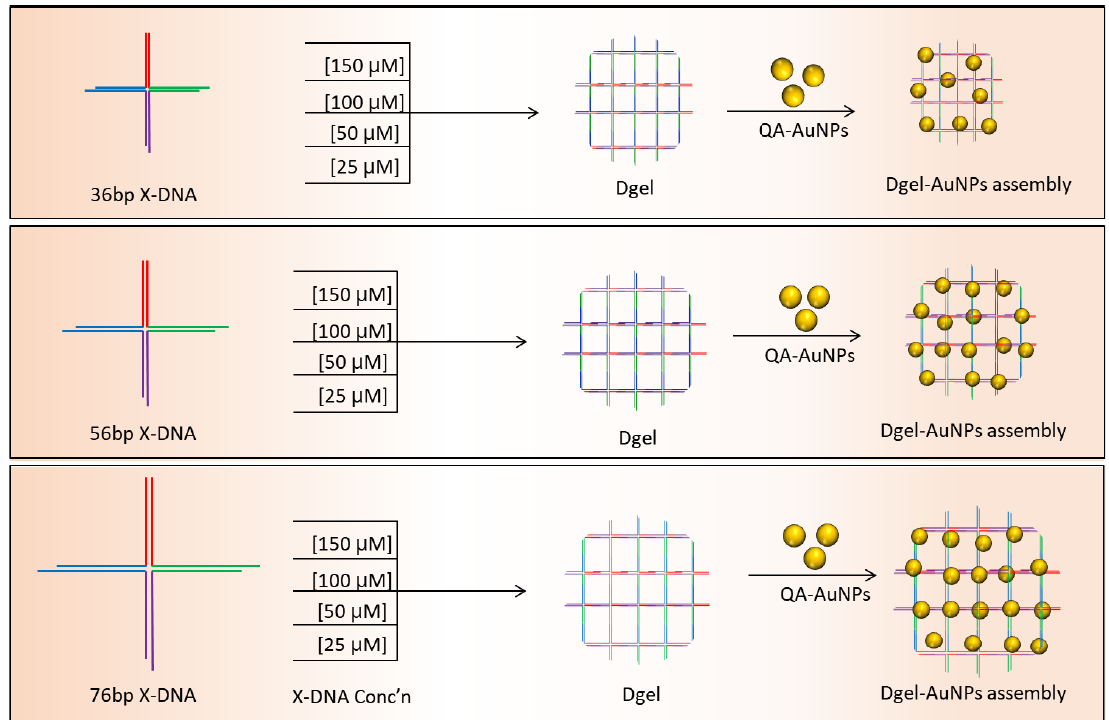
Scheme 1. Schematic representation of varied concentration-based Dgel engineering and Dgel: AuNP nano assemblies. nano